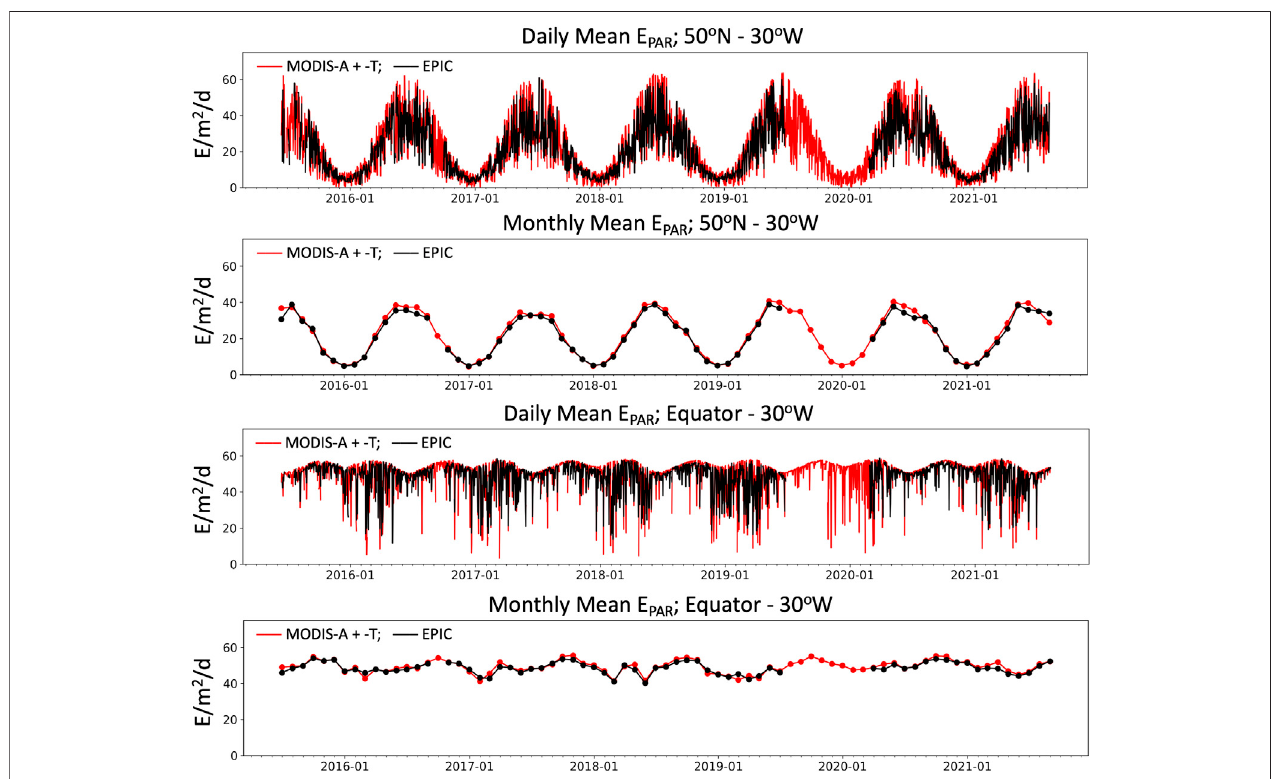
FIGURE 11 | Time series of EPIC and MODIS-A and -T daily and monthly mean E PAR at 50 ° N and 30 ° W (North Atlantic) and 0 ° and 30 ° W (Equatorial Atlantic). Seasonal cycle is pronounced at 50 N and small at equator; short term variability dominates at the equator.